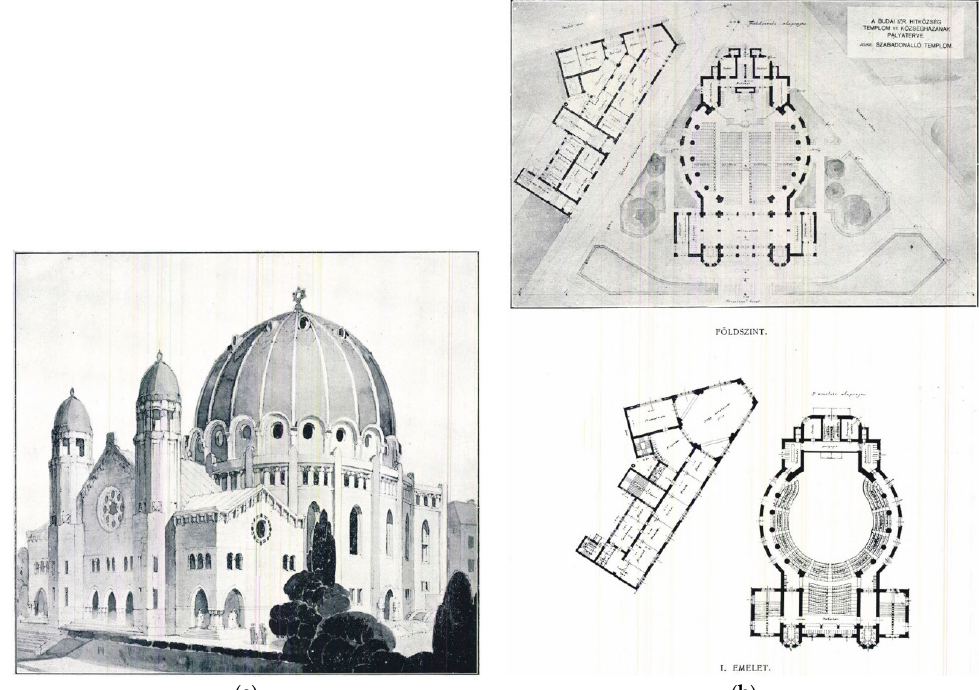
Figure 2. ( a ) Perspective view of Imre Gondos’ 2nd prize design (Imre Gondos, 1912). Source: Magyar E ́ pi ́ to ̋ mu ̋ ve ́ szet 1912, p. 18. ( b ) Floor plan of the synagogue building (Imre Gondos, 1912). Source: É p í t˝om˝uv é szet 1912, p. 18. (b) Floor plan of the synagogue building (Imre Gondos, 1912). Source: Magyar E ́ pi ́ to ̋ mu ̋ ve ́ szet 1912, p. 20. Magyar É p í t˝om˝uv é szet 1912, p.